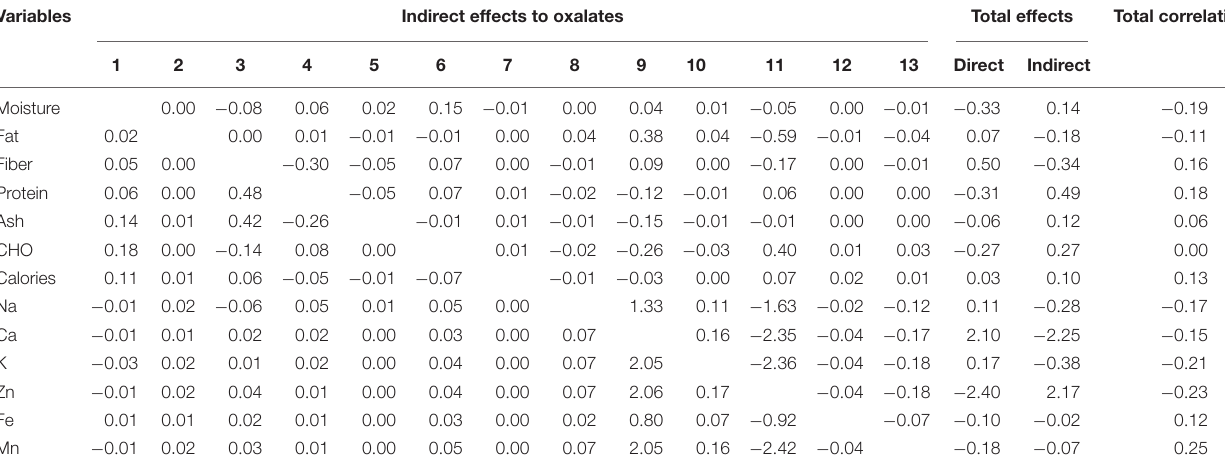
TABLE 3 | Pathway analysis showing direct and indirect effects of nutritional content on oxalates of spinach accessions. Variables Indirect effects to oxalates